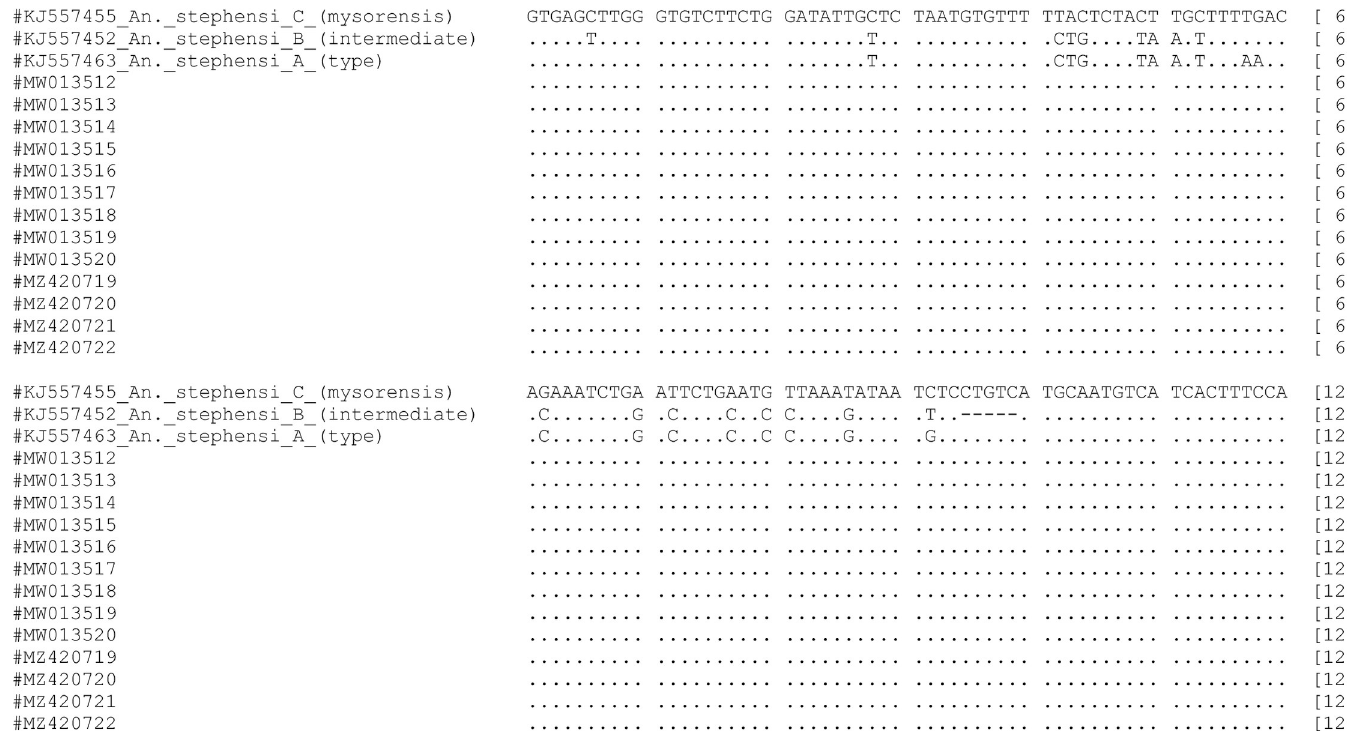
Fig 5. Multiple sequence alignment of Anste Obp1 partial sequence of lab strain with three known biological forms of An . stephensi .